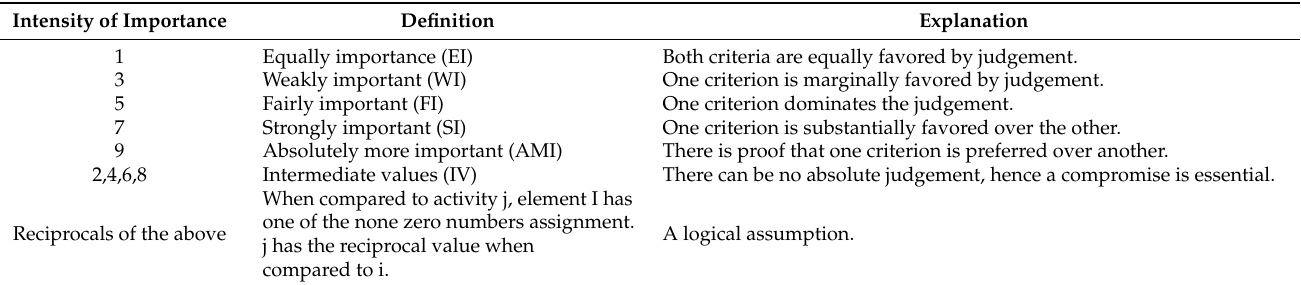
Table 15. Pairwise comparisons in AHP are done using Saaty’s 9-point scale.